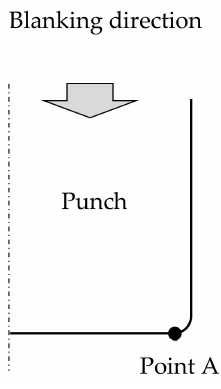
Figure 9. Stress estimation point in FEM analysis.